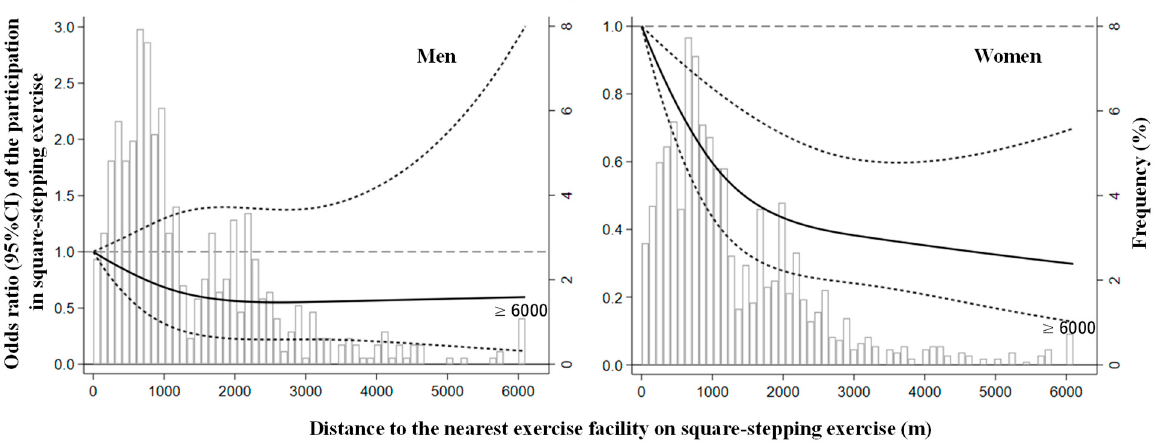
Figure 2. Odds ratio of participation in the square-stepping exercise and distance to a facility in men and women. The solid line represents the odds ratio, and the dashed line represents the 95% confidence intervals. Distance to the nearest exercise facility on square-stepping exercise distribution is represented by histograms in the background. Knots were placed at the 10th, 50th, and 90th percentiles of the distance to the exercise facility using < 100 m as the reference point. CI = confidence interval.